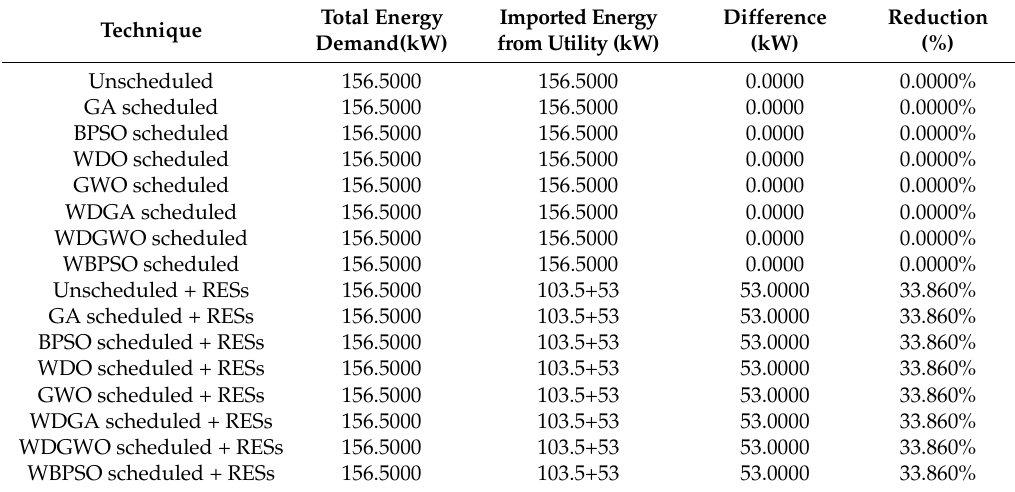
Table 11. Energy consumption with and without RESs.